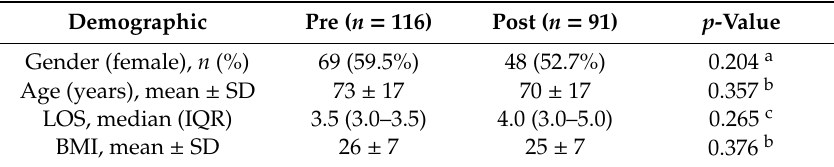
Table 1. Patient